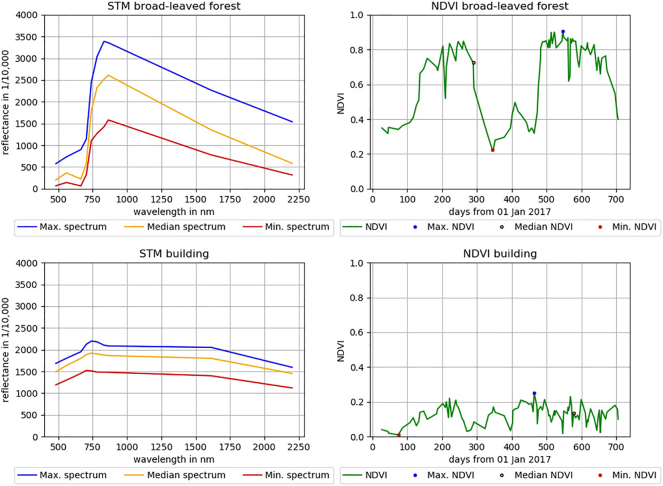
Left: Spectral-temporal metrics: Minimum, maximum and median spectra for a broad-leaved forest (top) and building pixel (bottom). Right: Maximum, minimum and median NDVI values for the same pixels over the two-year study period.